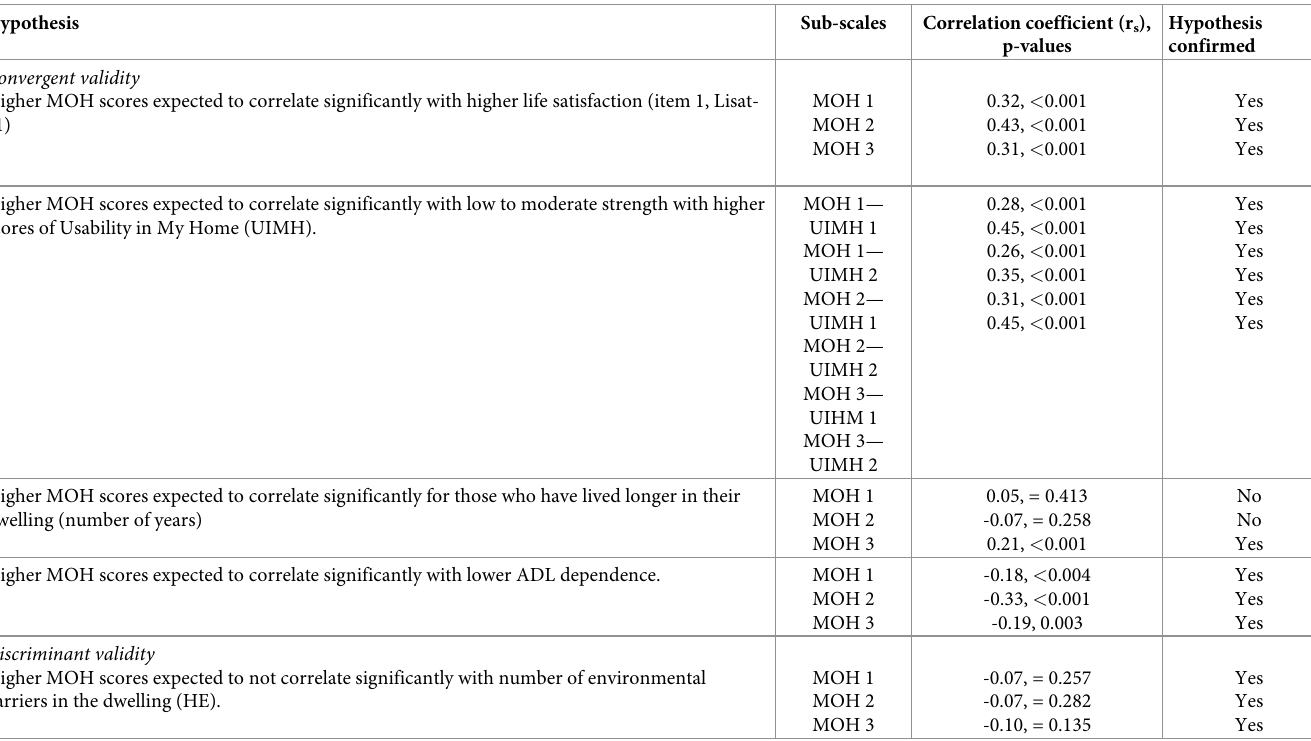
Table 4. Results of correlations between the 23-item version of the MOH instrument and life satisfaction, usability in the home, how long the participants have lived in their dwelling ADL dependence and number of environmental barriers. Hypothesis Sub-scales Correlation coefficient (r s ),